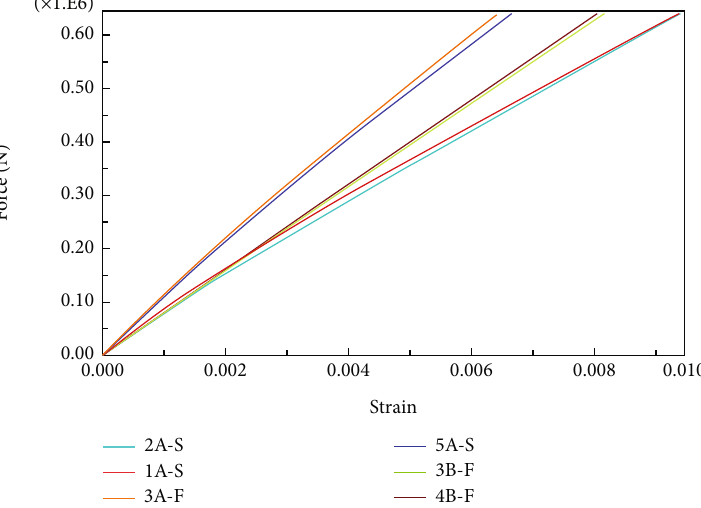
Figure 12: UMAT analysis load-strain progression.